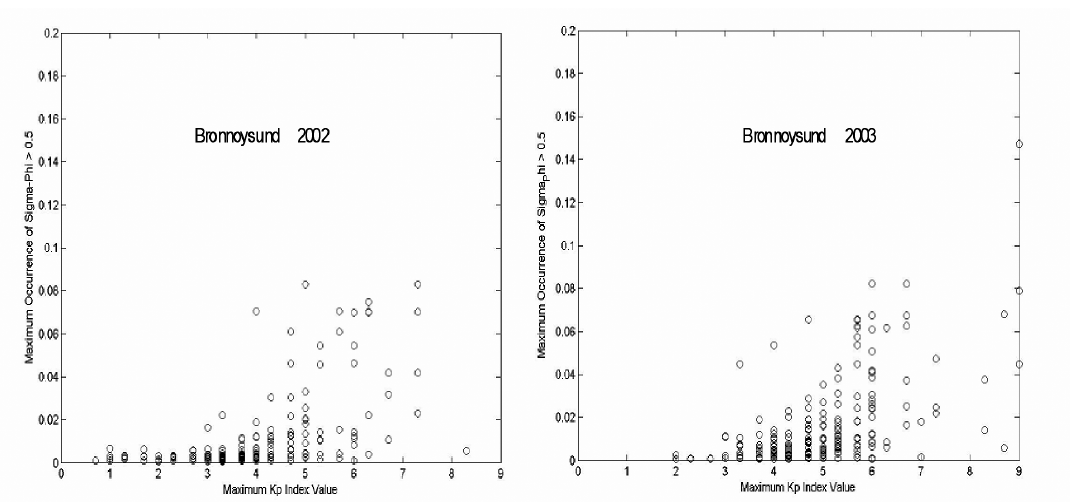
Fig. 17. Correlation between Kp and phase scintillation at Bronnoysund for the years of 2002 (left) and 2003